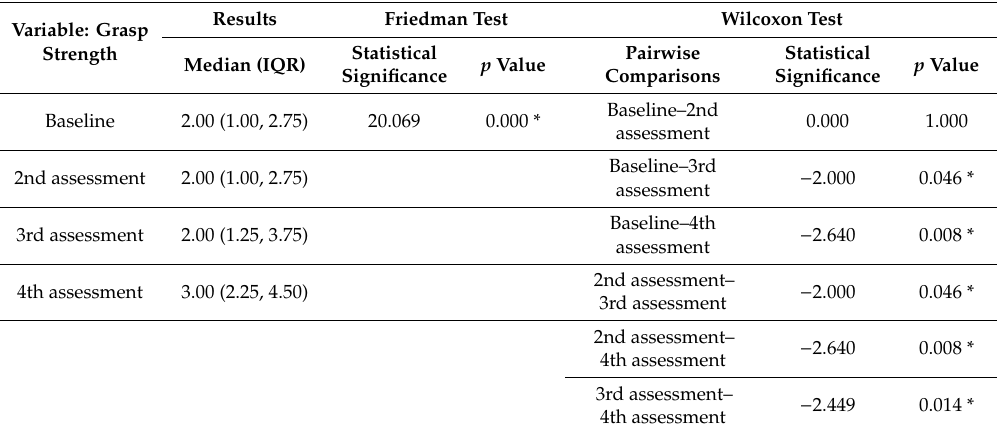
Table 5. Results and pairwise comparisons of grasp